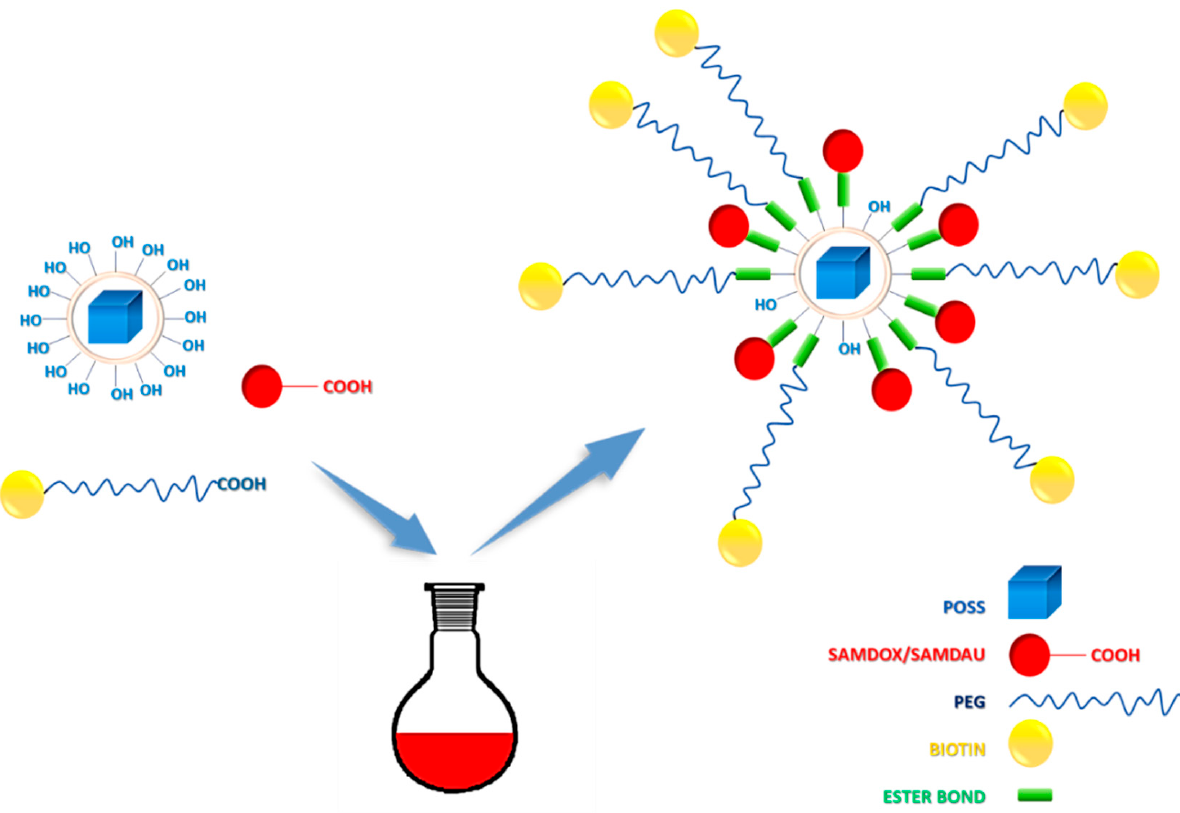
Figure 1. Synthetic scheme of [POSS(OH) 32 ] conjugates with anthracyclines, PEG and biotin. In this work, 6 POSS-anthracycline conjugates were synthesized: POSS conjugate contain- ing doxorubicin and PEG1 [ O -(2-carboxyethyl)- O (cid:48) -methyl-undecaethylene glycol; M w 588.68]— PossDoxPEG1 ( 4 ), doxorubicin and PEG2 [ O -Methyl- O (cid:48) -succinylpolyethylene glycol 2 (cid:48) 000; M w ~2100]—PossDoxPEG2 ( 5 ), doxorubicin and PEGB3 [ O -[2-(Biotinyl-amino)ethyl]- O (cid:48) -(2-carboxyethyl)polyethylene glycol; M w 3000]—PossDoxPEGB3 ( 6 ), daunorubicin and PEG1— PossDauPEG1 ( 7 ), daunorubicin and PEG2—PossDauPEG2 ( 8 ) and daunorubicin and PEGB3— PossDauPEGB3 ( 9 ) (Figure 2). The research was aimed to develop effective synthetic methods of silsesquioxane nanoconjugates with anticancer drugs. Such conjugates would be capable of releasing active drugs in cancer cells. The structure of all synthesized nanoconjugates was confirmed by NMR spectroscopy, FTIR, and